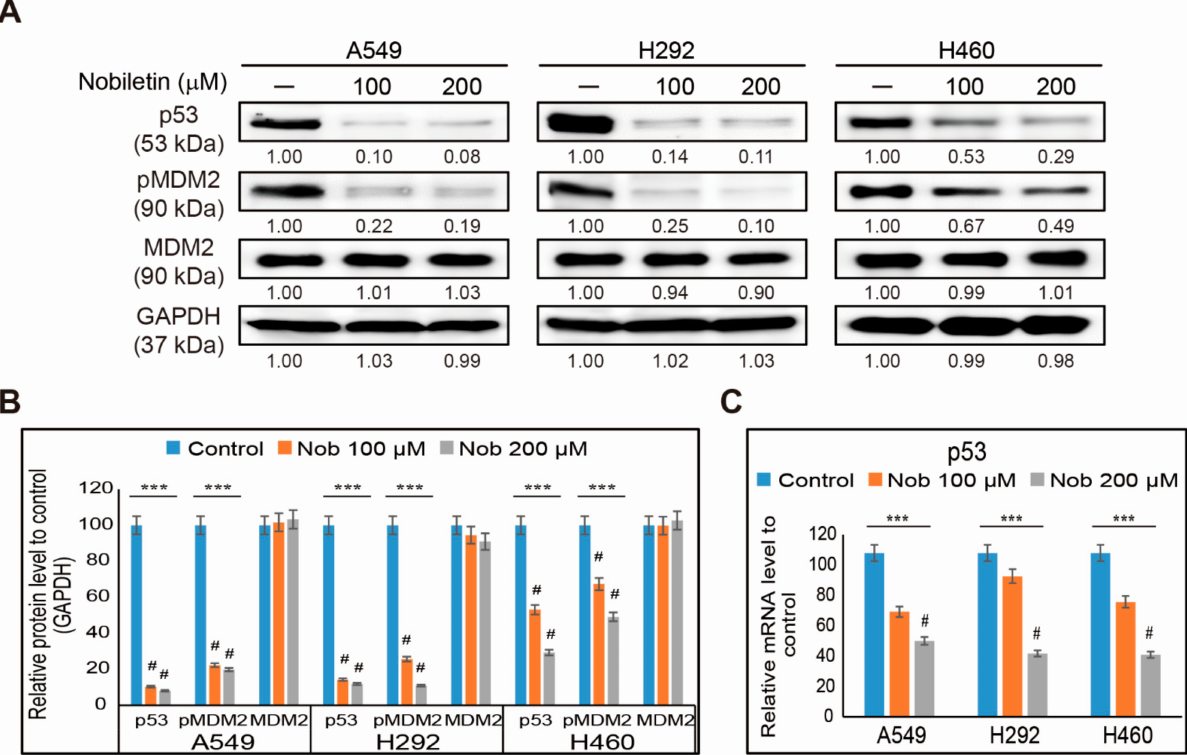
Figure 4. Nobiletin suppresses p53-MDM2 expressions. ( A ) Western blotting of total proteins isolated from A549, H292, and H460 cells after 48 h treatment with 100 and 200 µ M nobiletin showed the expression of p53, MDM2, and phospho-MDM2 proteins. ( B ) Representative expression of proteins was quantified by densitometry and normalized to GAPDH protein. Control proteins were set to 100%. All data repeated three times for confirmation. *** p < 0.001 (ANOVA test). # p < 0.001 vs. control. ( C ) Real-time qPCR of the expression of p53 genes ( TP53 ) in NSCLC cells after treatment with 100 and 200 µ M nobiletin for 48 h. The representative expression of p53 mRNA is shown; Cp values were then normalized to GAPDH mRNA. Controls are set to 100. *** p < 0.001. (ANOVA test), # p < 0.001 vs. control. Nob: